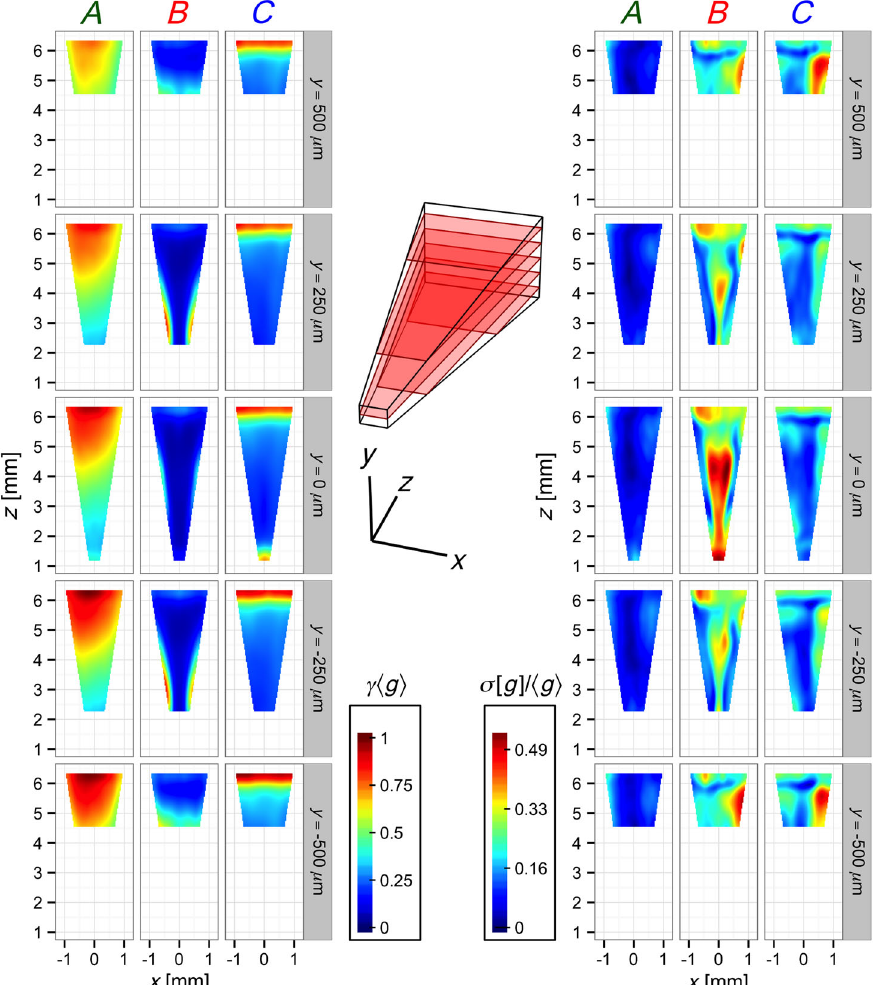
FIG. 10. I ¼ 0 . 25 I 0 spatial distributions of microbes in imaging volume. γ h g i and σ ½ g (cid:2) = h g i are defined in the caption to Fig. 4 for the I ¼ I 0